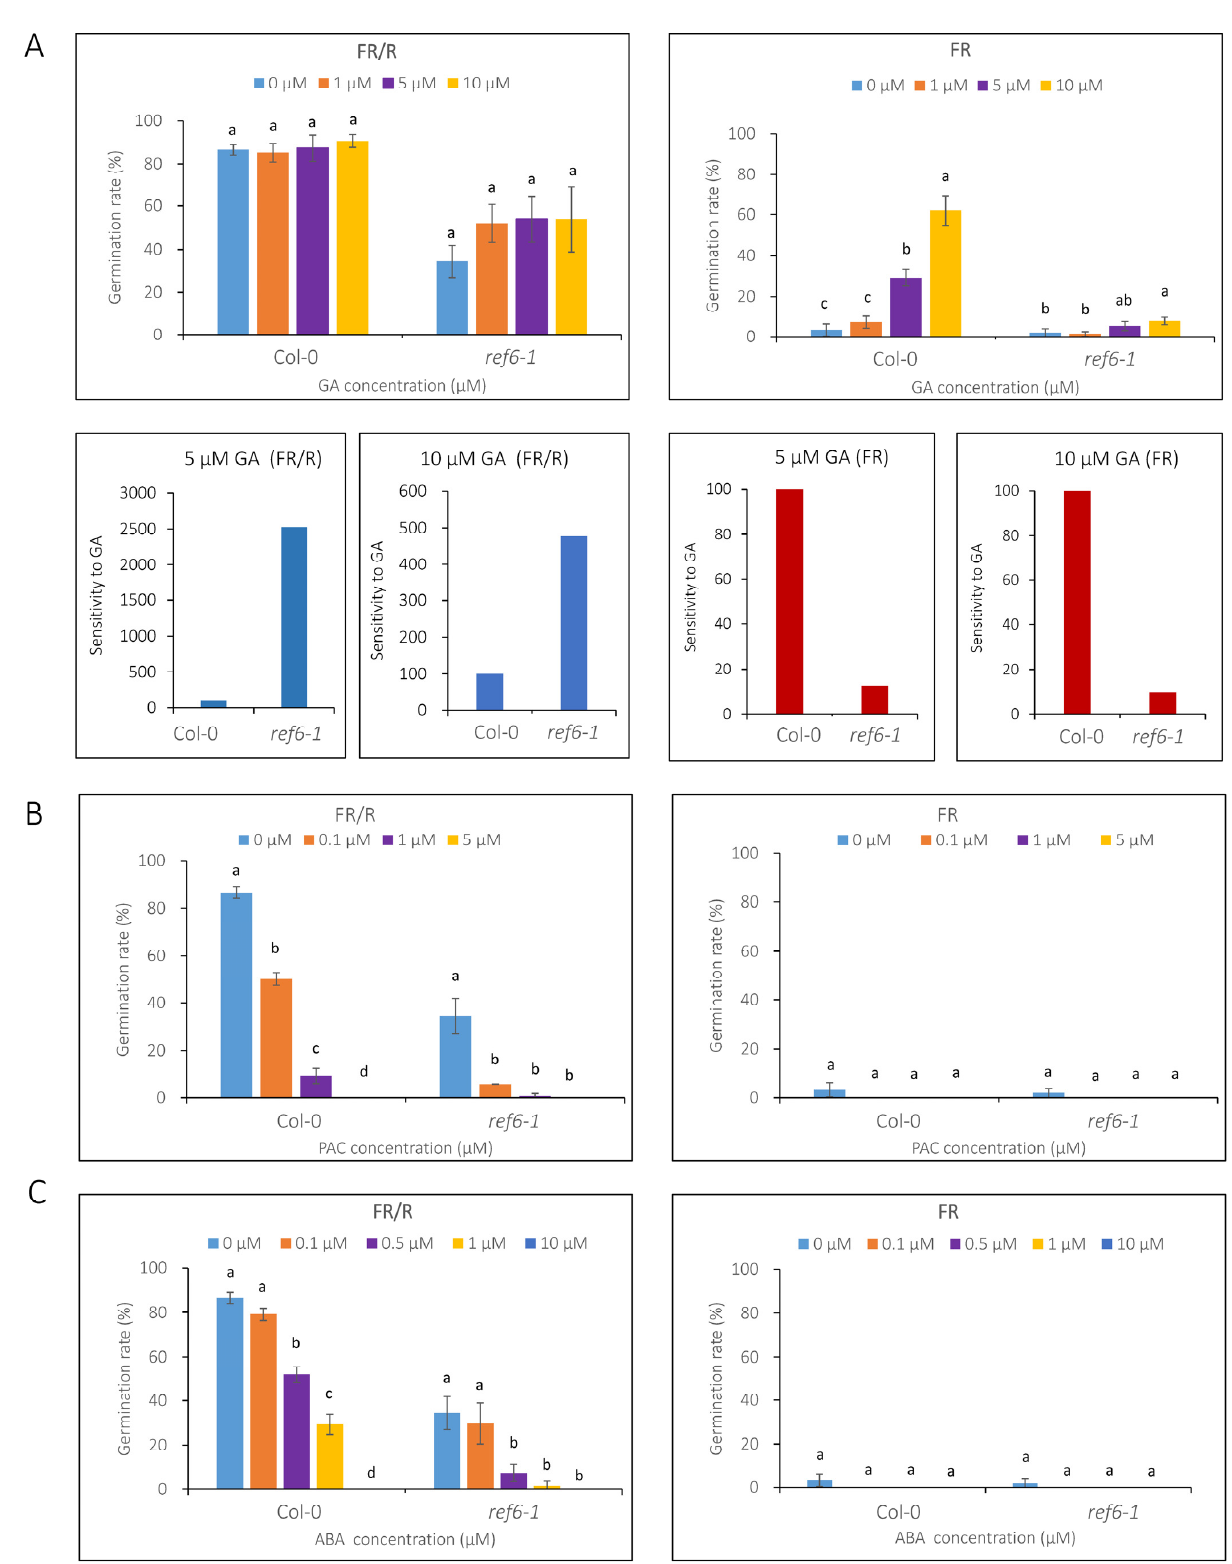
Figure 5. Effect of GA, PAC and ABA treatments on the seed germination of ref6 mutant under phyB-dependent germination conditions. ( A ) Germination rates of ref6-1 supplemented with 0, 1, 5 and 10 µ M GA under phyB-on (FR/R) and phyB-off (FR) conditions. GA sensitivity was calculated